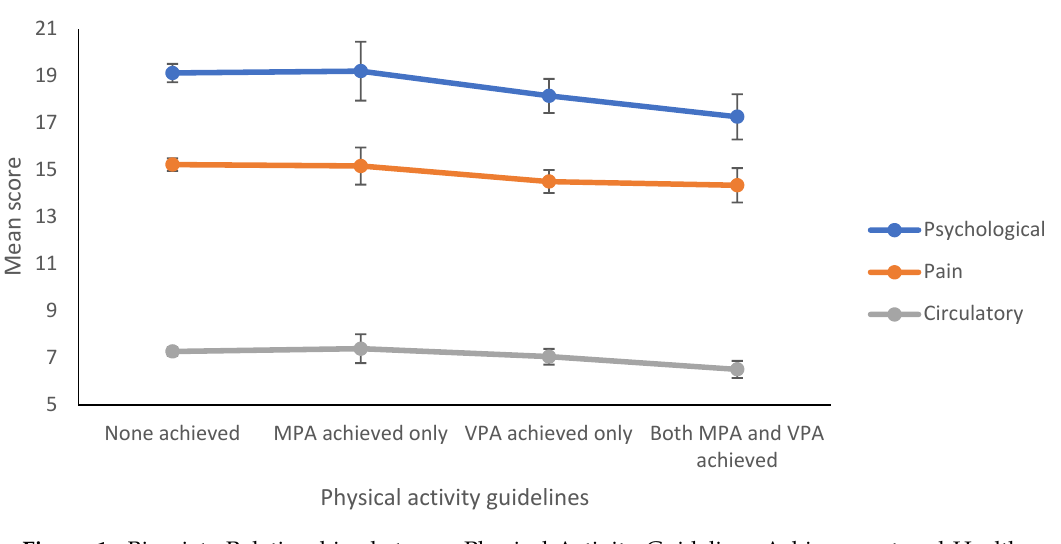
Figure 1. Bivariate Relationships between Physical Activity Guidelines Achievement and Health Complaints Among Undergraduates, University of Turku, Finland. (Circle represents the mean score, error bars are 95% CIs for the mean).